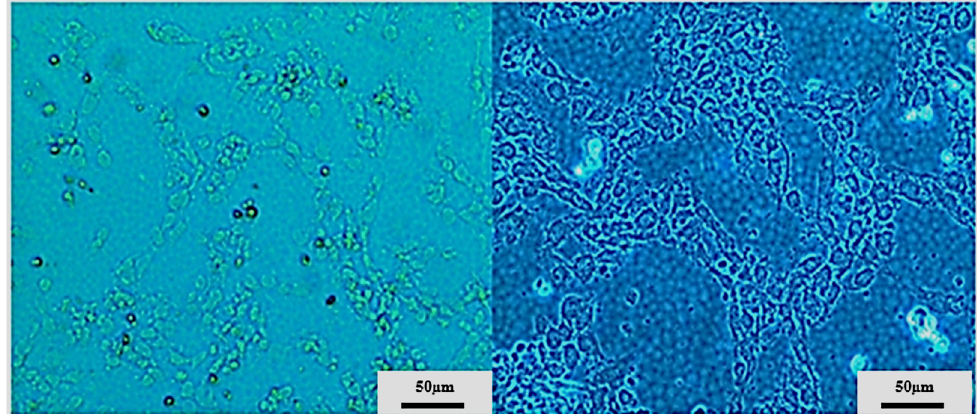
the cell growth stage, S for the DNA synthesis stage, and G2 for pre-mitosis stage.